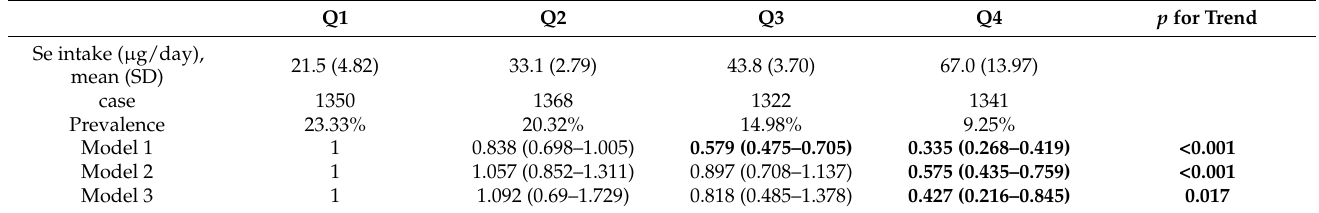
Table 2. Logistic regression analysis of CKD status and dietary selenium (quartile) in adults.